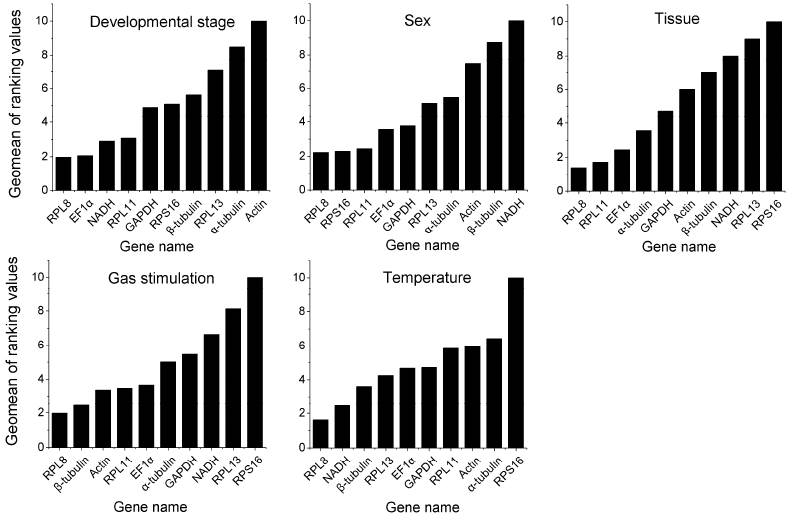
Figure 2. Stability ranking of 10 candidate reference genes in C. hemipterus under different treatment conditions analyzed by RefFinder (integrates four major computational programs: geNorm, NormFinder, BestKeeper, and ∆ Ct). The lower the value, the higher the stability. Insects 2022 , 13 , x FOR PEER REVIEW